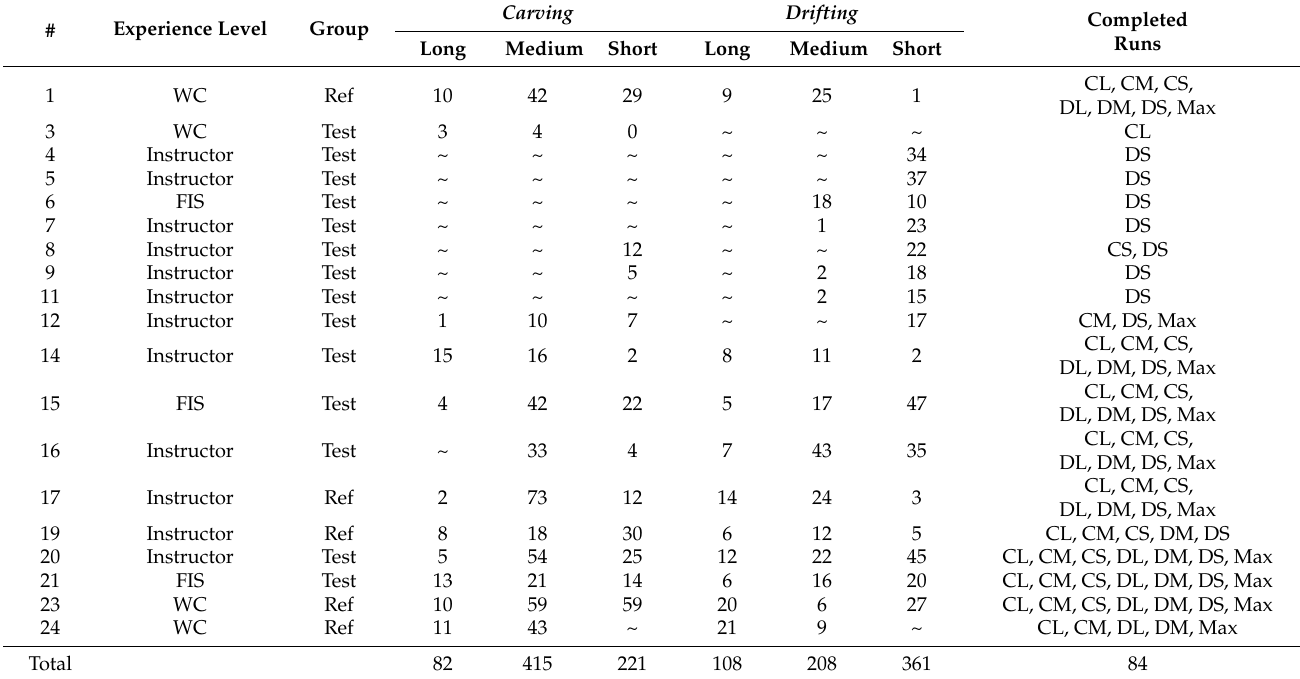
Table 1. Turns classified per participant as carving or drifting in long, medium, and short radii. Although participants were instructed to complete turns of specific styles, some turns were classified as different styles or radii. Experience levels: WC corresponds to retired world cup ski racers, while FIS corresponds to retired FIS level ski